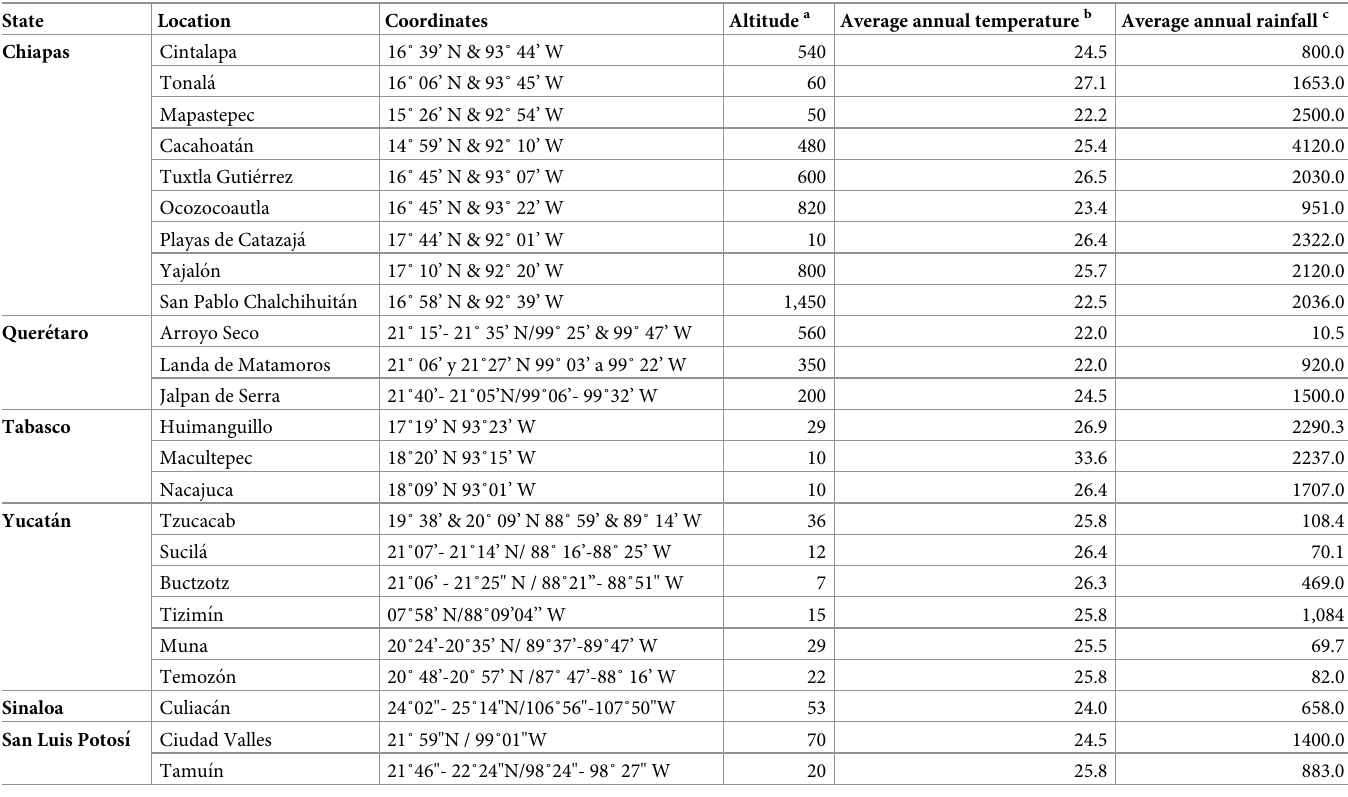
Table 1. Geographical and climatic characteristics of the sampling